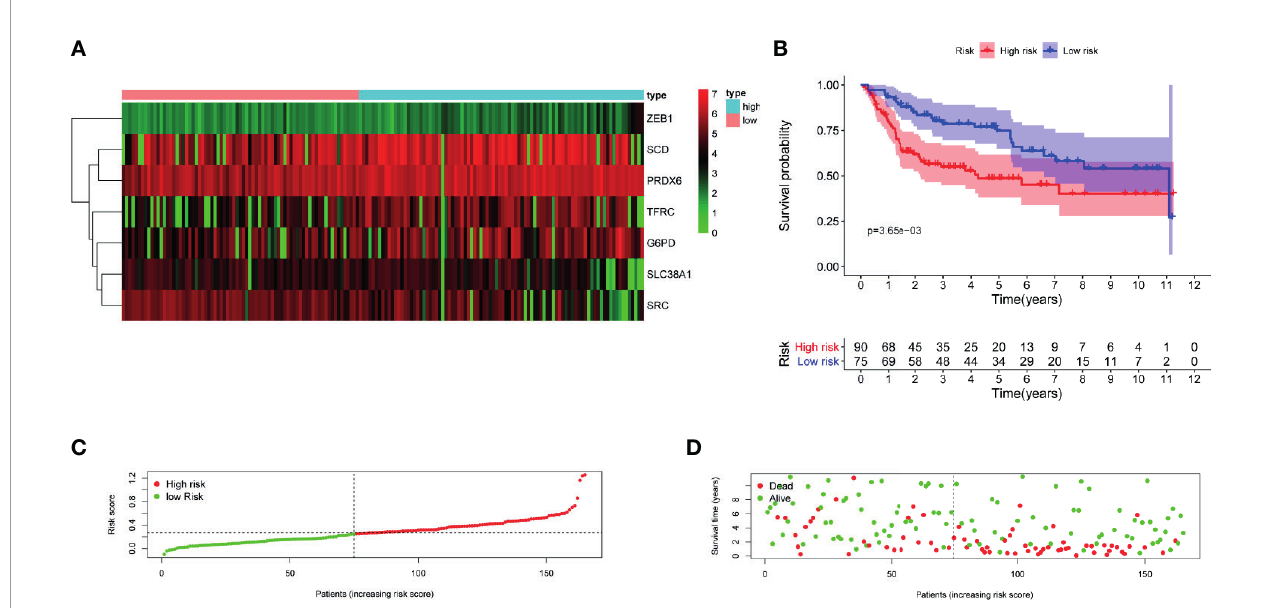
FIGURE 5 | Validation of the constructed FRG prognostic signature in GSE13507. (A) Heatmap of seven genes expression between high- and low-risk score group in GSE13507 cohort. (B) Kaplan – Meier survival curve. (C) Risk score curve plot. The dotted line indicates the individual distribution of risk score, and the patients are categorized into low-risk (green) and high-risk (red) groups. (D) Risk score scatter plot. Red dots indicate the dead patients, and green dots indicate the alive. With the increase in risk score, more patients died. FRG, ferroptosis − related gene.